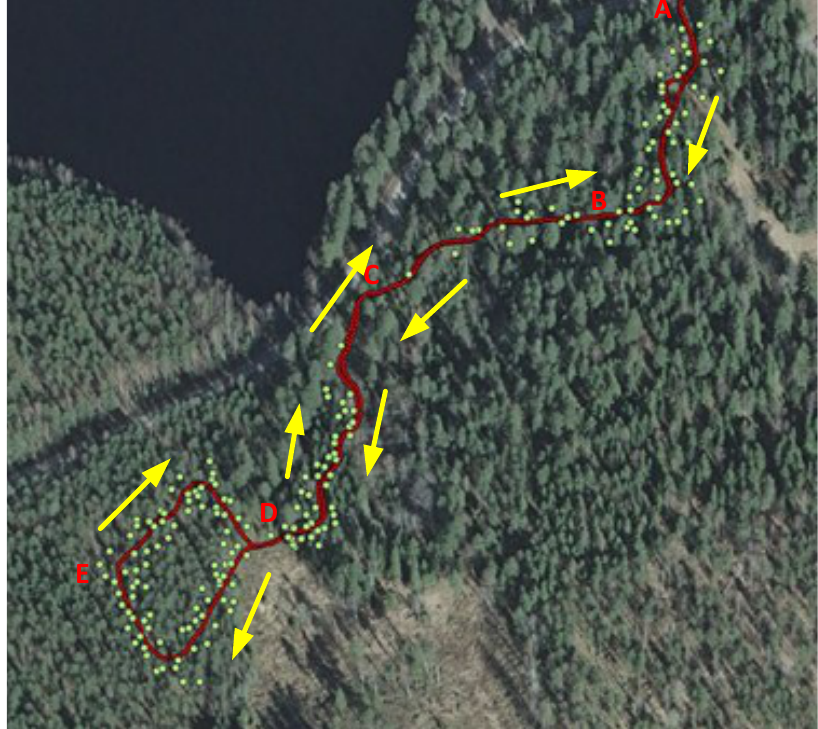
Figure 5. Reference trajectory (red) and reference trees (green) (Background orthoimage: NLS 2012).